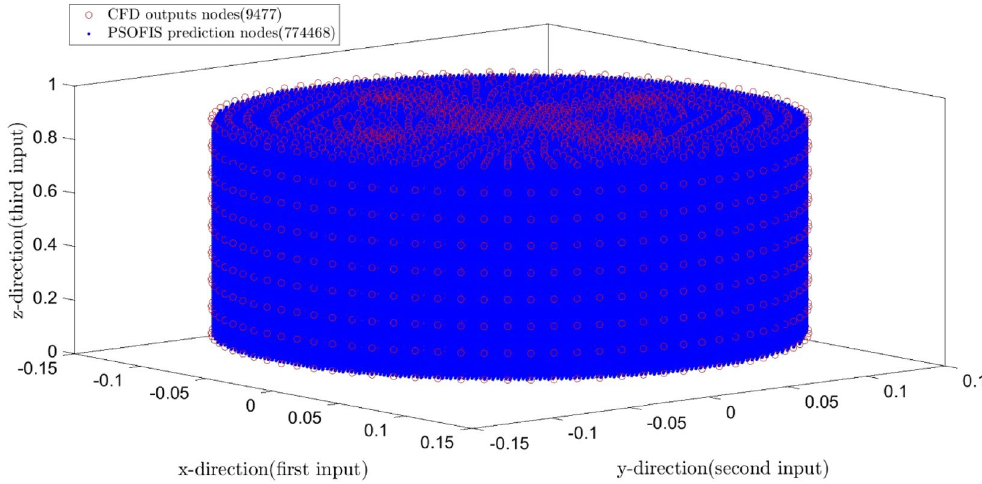
Figure 11. Remeshed domain from 9477 to